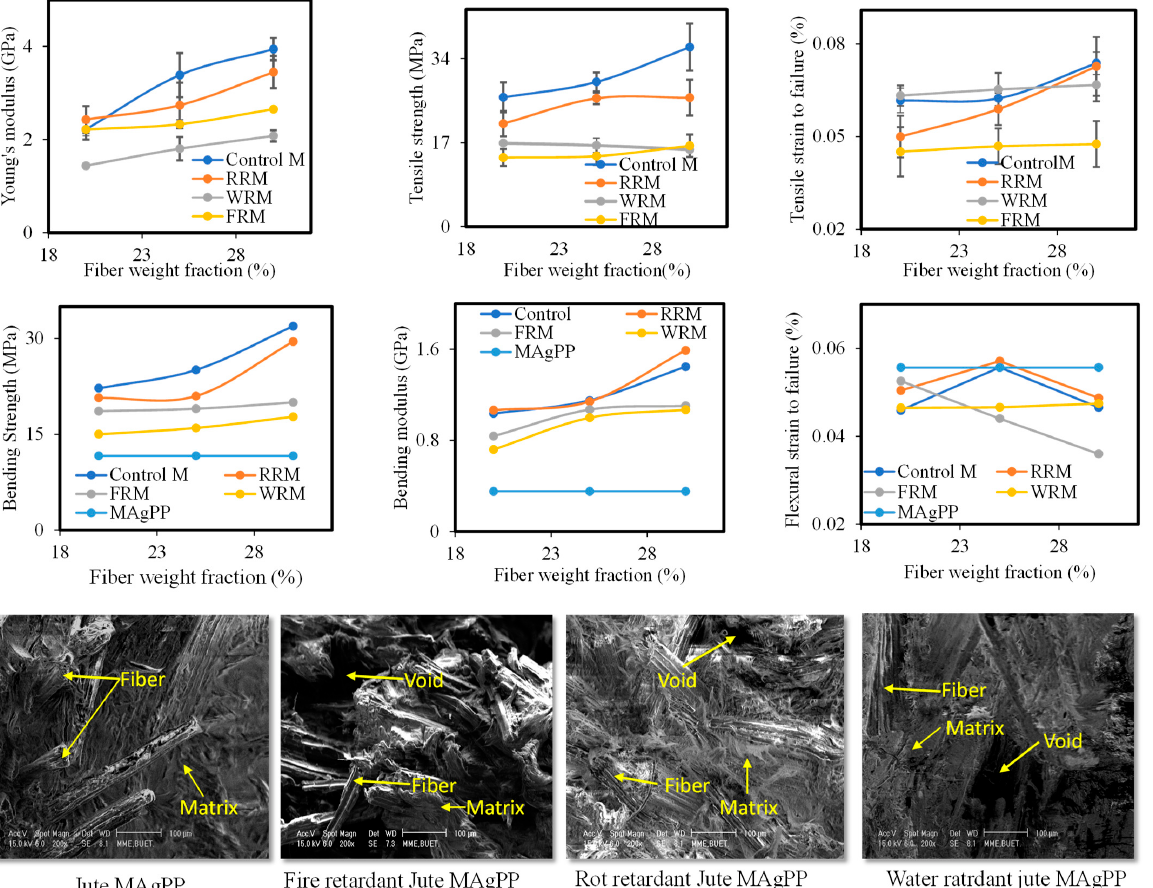
Figure 17. Mechanical properties and fractured surface characteristics of jute fiber reinforced thermoplastics composite fire-retardant (FRM), rot-retardant (RRM) and water-retardant (WRM) treatments on the jute fiber. Control M indicates no fiber treatment [43].